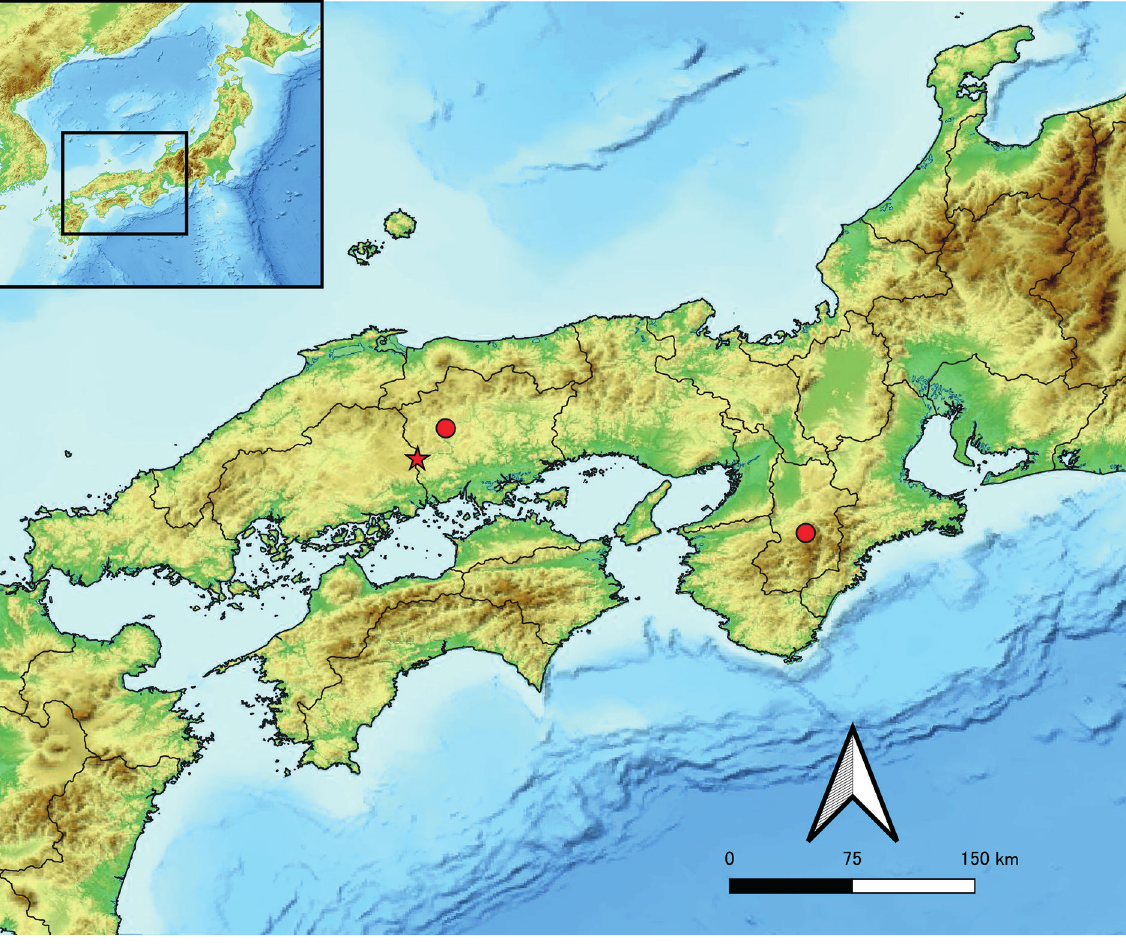
Fig. 6. Distribution of Nihonella chika gen. et. sp. nov. in Western Japan. The star refers to the type